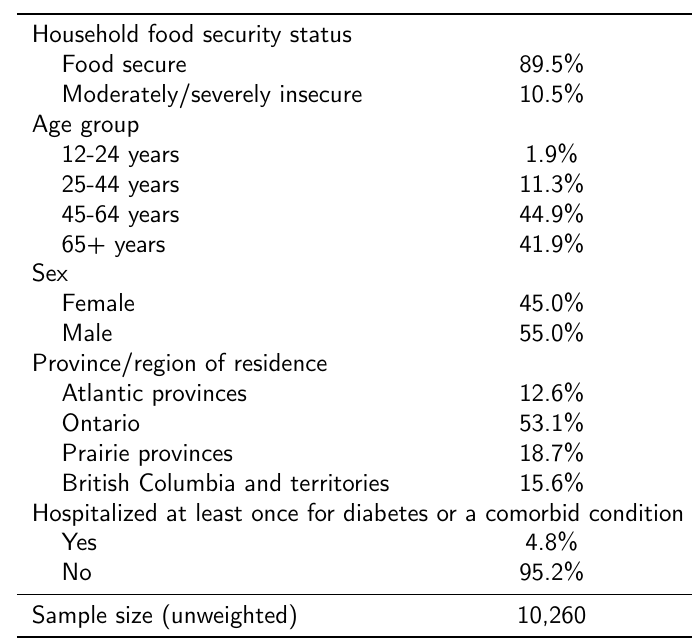
Table 1: Percentage distribution of the community-dwelling population aged 12 and over living with diabetes by selected charac- teristics, Canada, 2006-2011